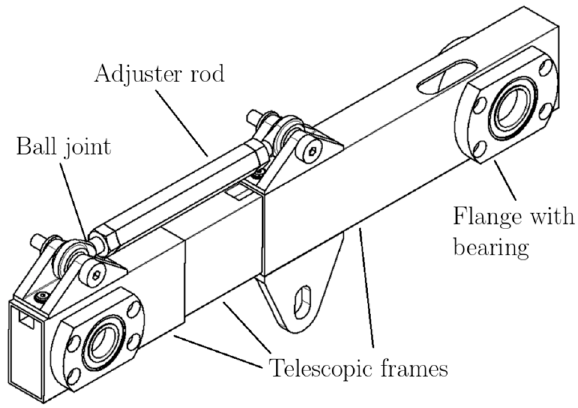
Figure 7. Track frame connecting the sprocket shaft and the idler shaft.